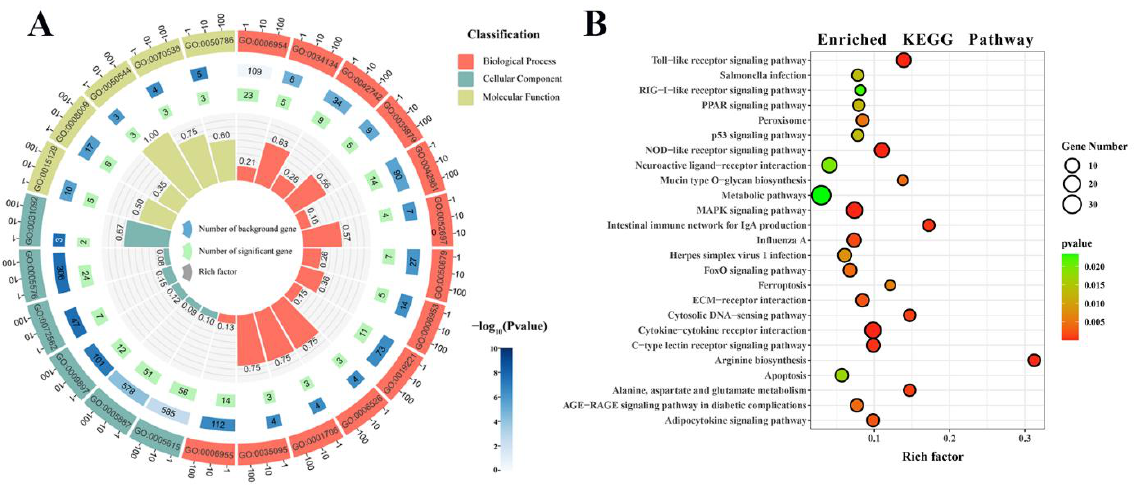
Figure 5. Analysis of GO and KEGG pathway enrichment of DEGs in goose liver. ( A ) GO enrichment analysis circle plot: The top 13 most significant biological processes, the top 6 most significant cellular components, and the top 5 most significant molecular functions. The outermost layer of the represents the enriched GO ID. The second layer represents the number of background genes in the pathway, and the depth of the color represents the size of the p value. The third layer represents the number of significant genes. The innermost columnar represents the rich factor, with red representing the biological process, light green representing the cellular component, and earthier yellow representing the molecular function. ( B ) The top 25 KEGG enrichment bubble plot: the size of the circle represents the number of genes, and the depth of the color represents the size of the p value. Table 3. GO ID associated with the GO term.